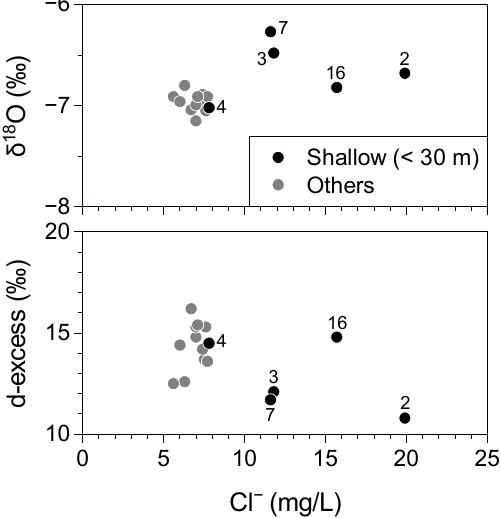
Figure 6.  18 O and d-excess values for groundwater plotted against the Cl − concentrations.